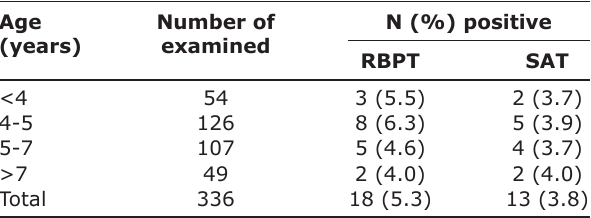
Table-2: Seroprevalence of bovine brucellosis in Bauchi State, Nigeria based on